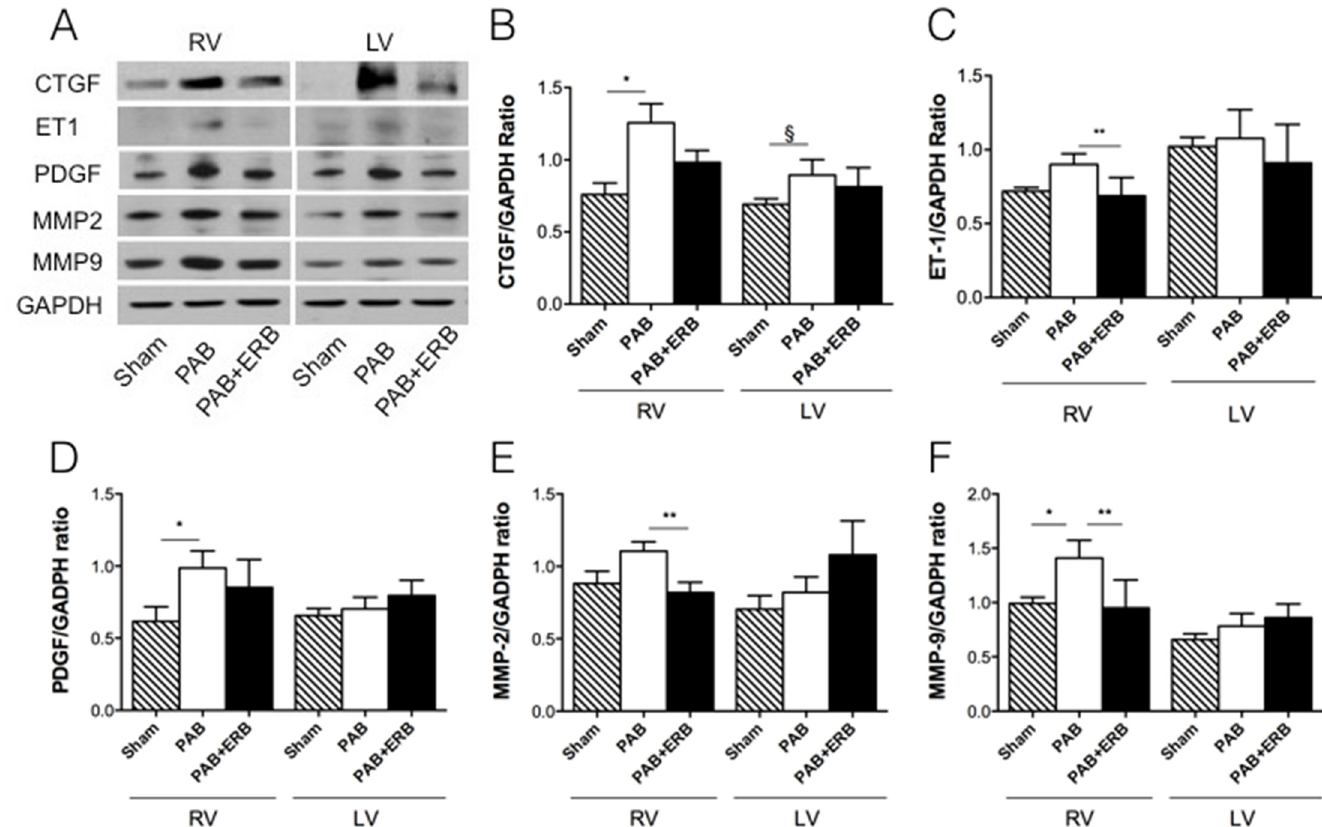
Fig 3. Western blot results of proteins involved in the signaling pathway of fibrosis. Western blot analyses with quantification of Connective Tissue Growth Factor (CTGF), platelet derived growth factor (PDGF), and matrix metalloproteinases 2 and 9 (MMP 2 and 9) proteins level at 6-weeks after PAB. A) Western blot examples of the respective proteins. B) CTGF increased significantly with PAB compared to sham in the RV ( * p (cid:1) 0.01), in the LV CTGF also increased with PAB compared to sham (§ p < 0.05). Addition of macitentan did not significantly decrease CTGF. C) the protein level of endothelin-1 (ET-1) decreased significantly with addition of macitentan compared with the PAB group ( * p (cid:1) 0.05). D) PDGF increased in the RV with PAB compared with sham ( * p (cid:1) 0.05). E) MMP-2 in the RV showed a trending increase with PAB and decreased with addition of macitentan compared with PAB ( * p (cid:1) 0.05) F) MMP-9 in the RV increased with PAB compared with sham ( * p < 0.05), addition of macitentan decreased MMP-9 ( ** p (cid:1) 0.05). Glyceraldehyde-3 – phosphate dehydrogenase (GAPDH) was used as the internal control. Sham (n = 4), PAB-group (n = 5), and PAB+ERB (n = 5). RV: right ventricle, LV: left ventricle, PAB: pulmonary artery banding, and ERB: endothelin receptor